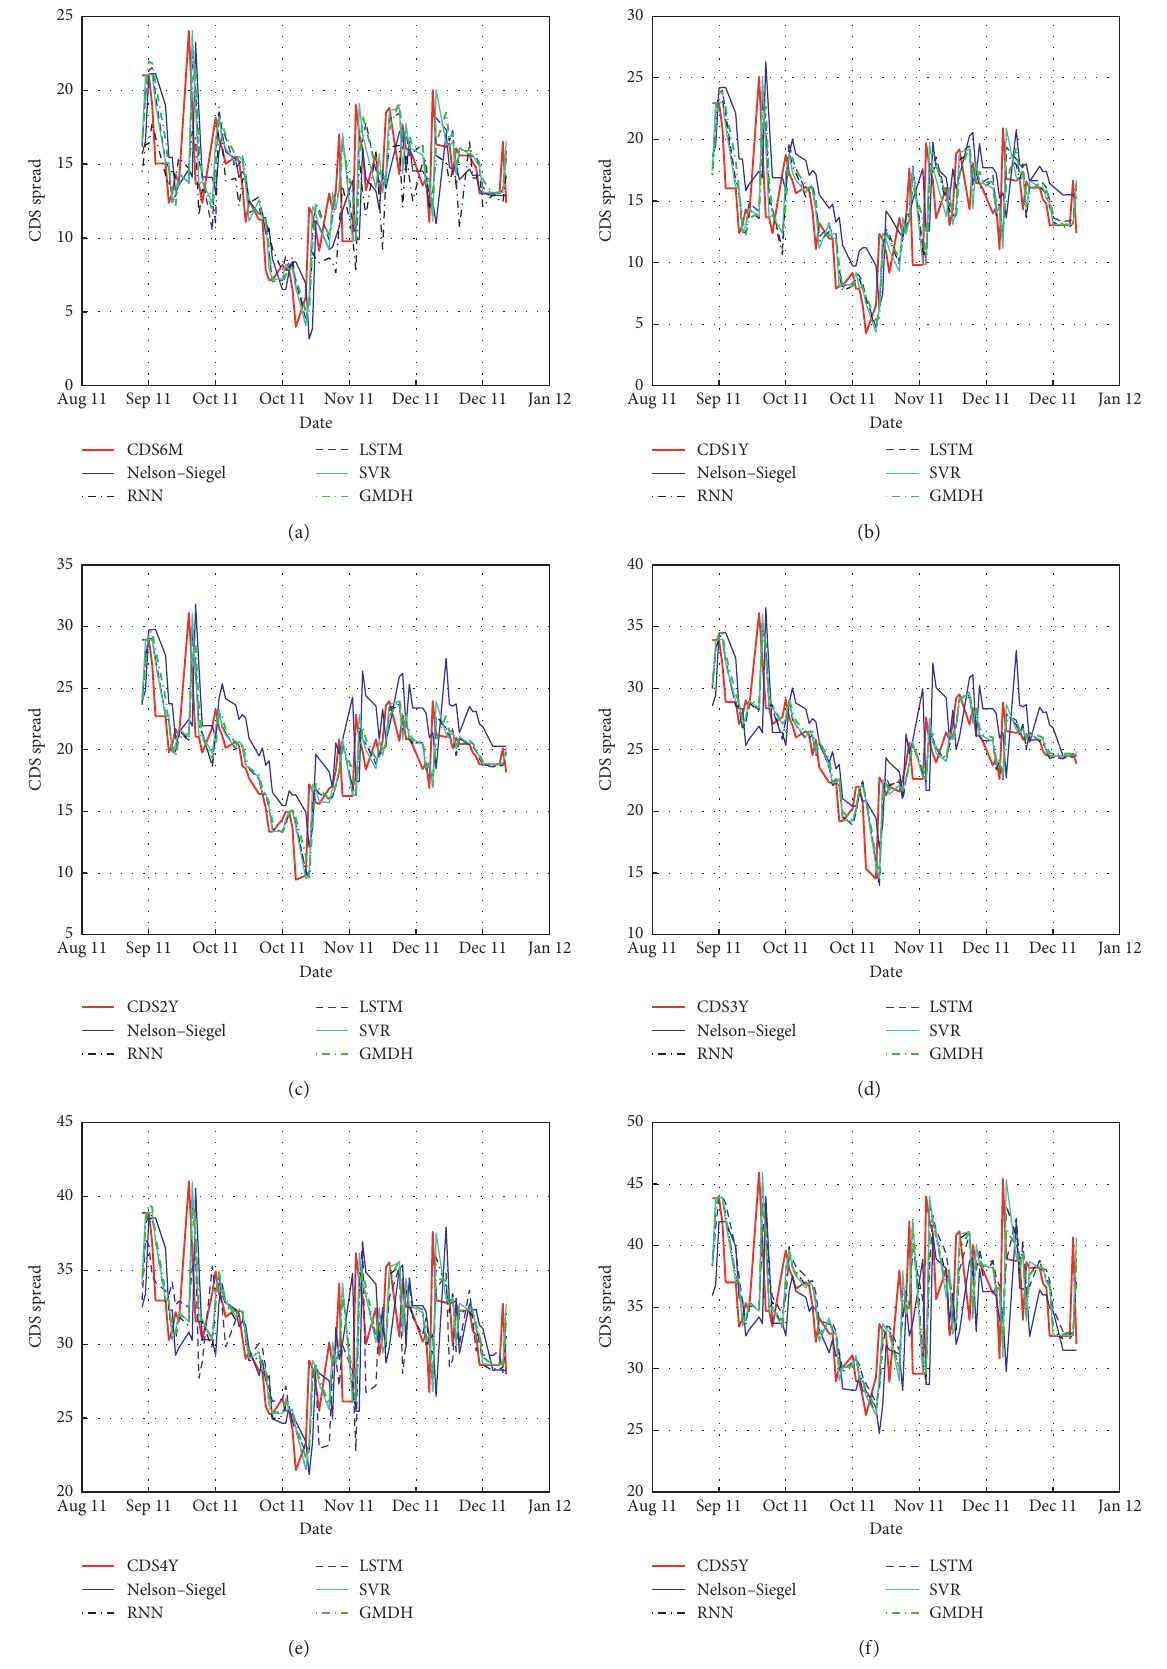
Figure 8: Predictions of each model and target CDS term structure from six months to five years maturity for test dataset 2 with the subperiod 1 training set (case